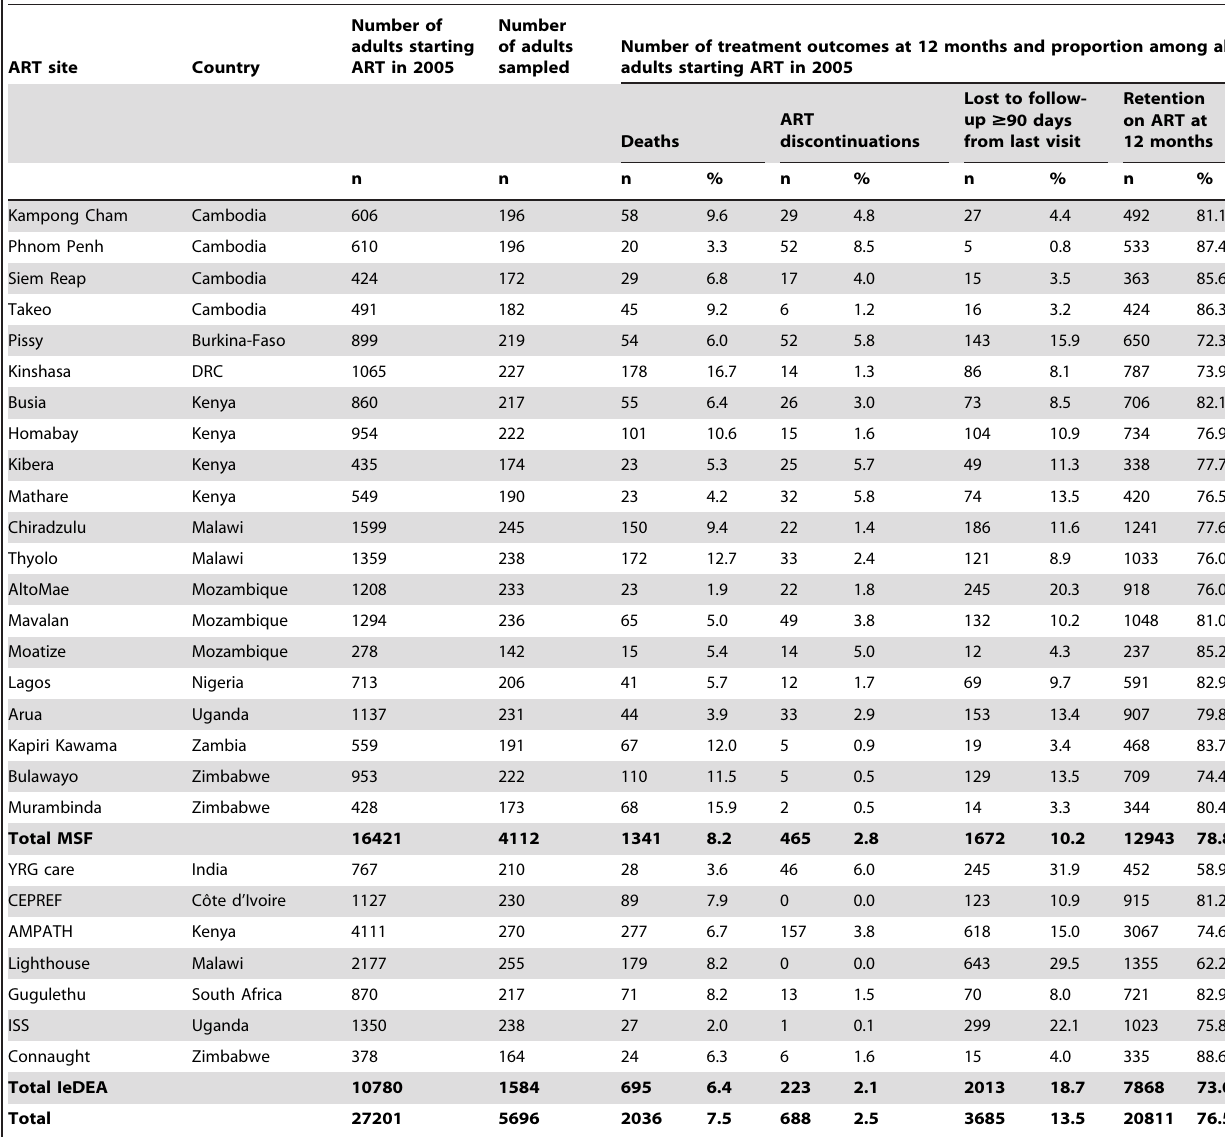
Table 1. Number of patients analysed and treatment outcomes at 12 months of ART by cohort on the full